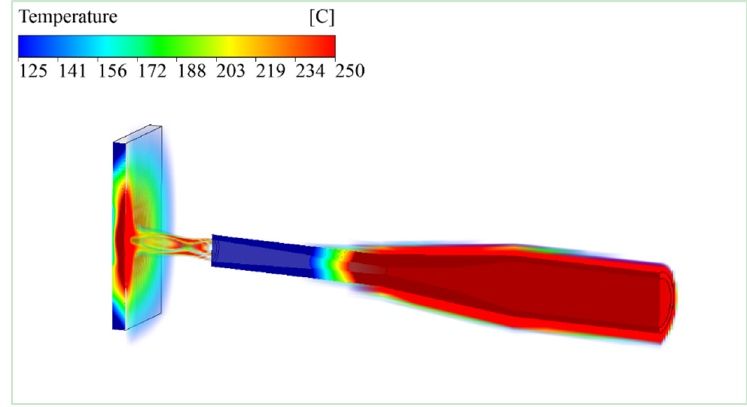
Figure 8. Simulation of temperature distribution for cold spray supersonic jet at 800 °C and 3 MPa estimated holistically from nozzle stagnation zone to the substrate surface, predicted by 3D multicomponent